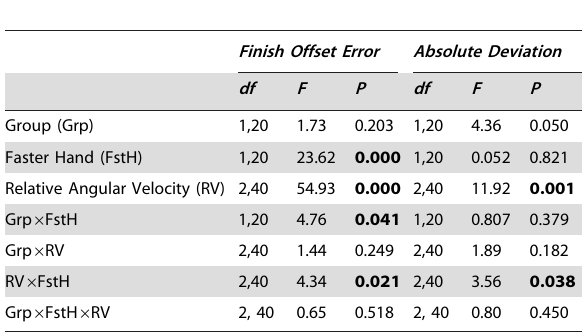
Table 2. Summary of ANOVA results on Finish Offset Error and Absolute Deviation (2 6 2 6 3).